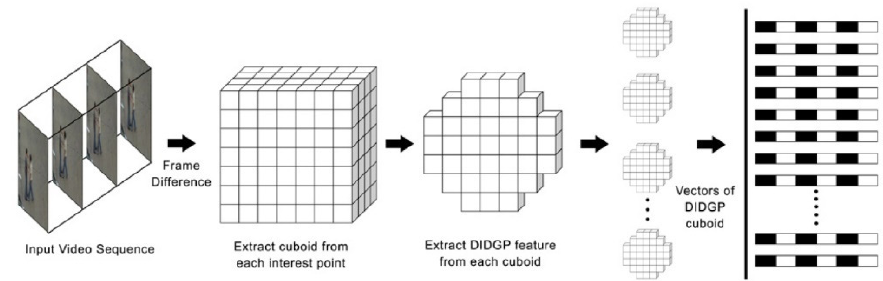
Figure 6. Extraction of raw features from a video sequence.